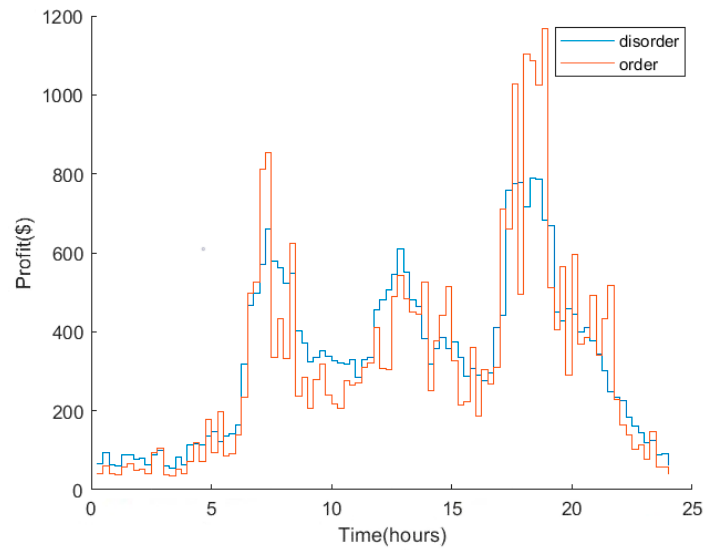
Figure 15. Profit comparison.